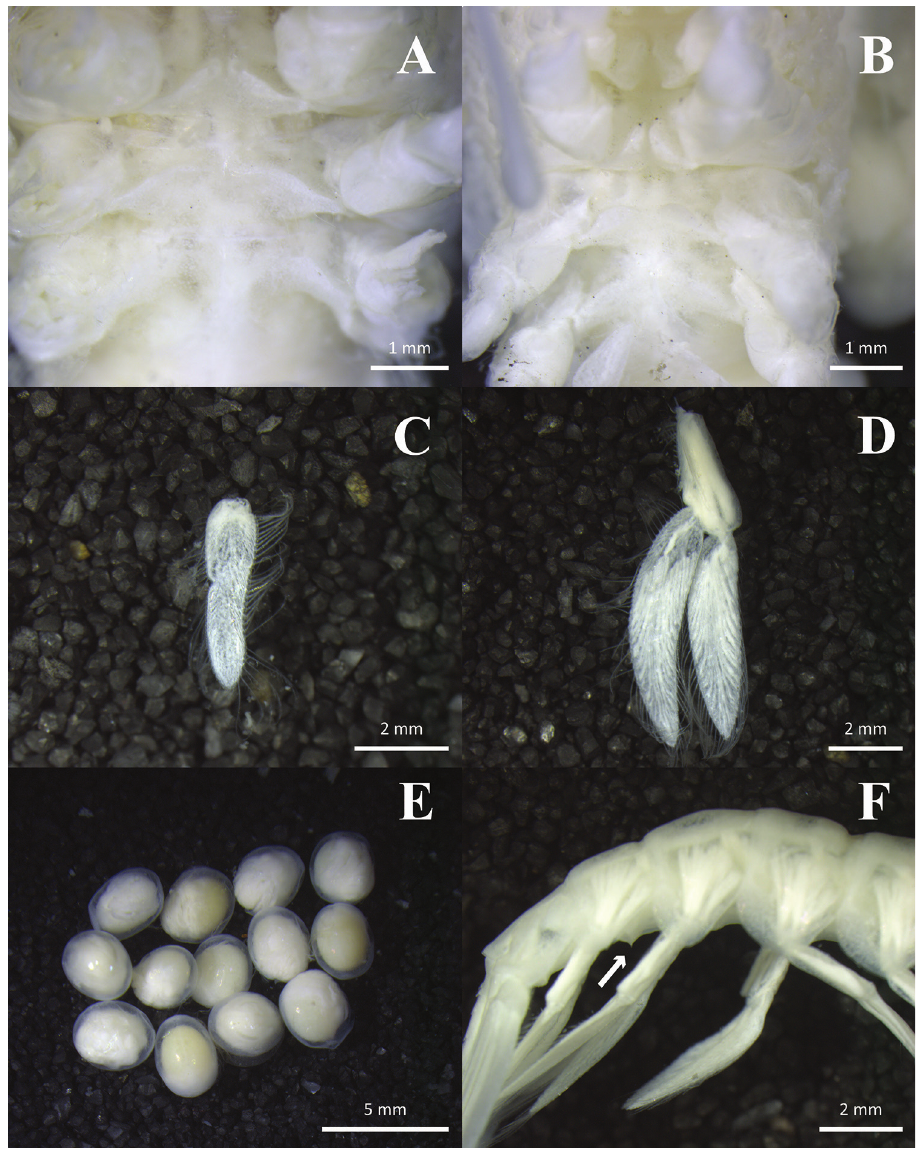
Figure 5. Spongicoloides weijiaensis sp. n. Holotype female: A thoracic sternites, ventral view C first pleo- pod, lateral view D second pleopod, lateral view E eggs, outer view. Paratype male: B thoracic sternites, ventral view F second to sixth pleonites, showing spine of fifth sternite, lateral First pleopod (Fig. 5C) smallest, uniramous. Second to fifth pleopods biramous. Second pleopod (Fig. 5D) with protopod shorter than rami, bearing ovipositing setae on dorsal and ventral margins; mesial surface with ridge bearing ovipositing setae.